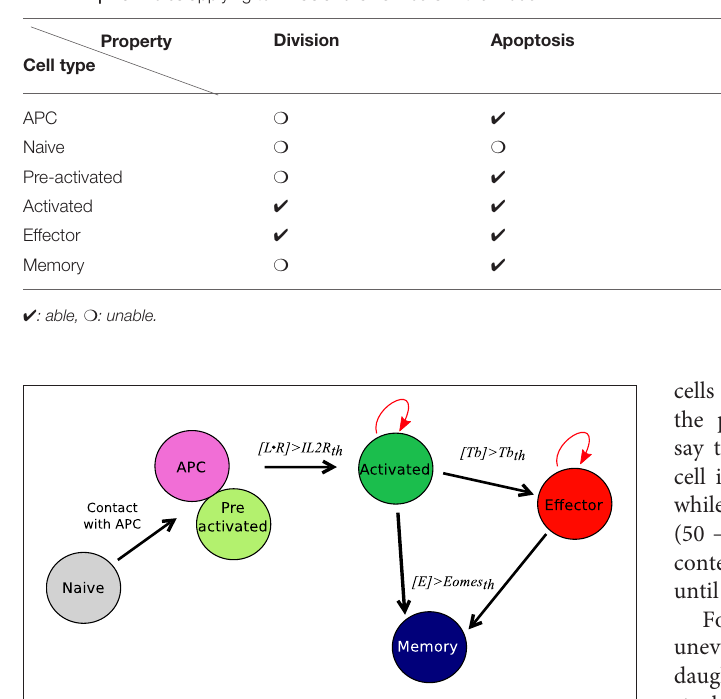
FIGURE 2 | CD8 T-cell differentiation scheme. Red arrows: proliferation; black arrows: differentiation; th =